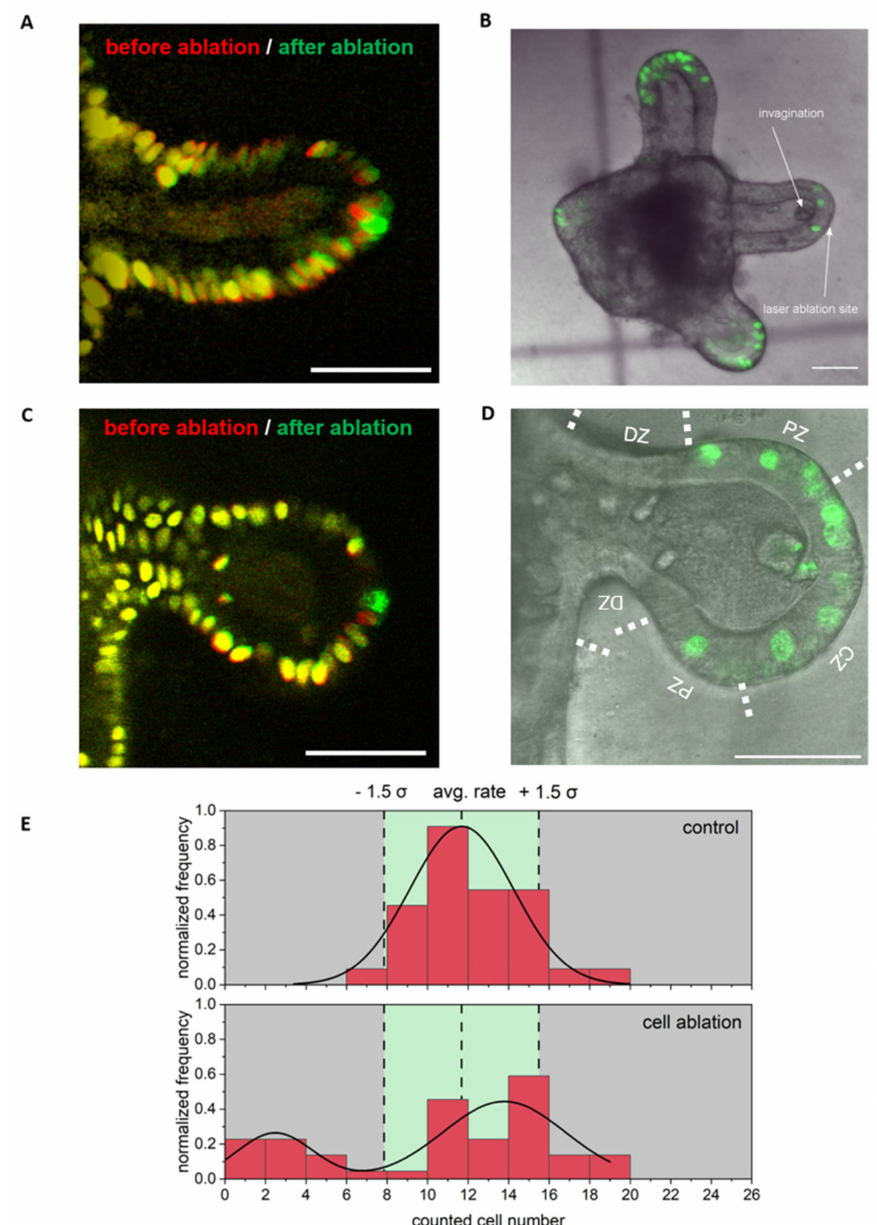
Figure 6. Regeneration and proliferation after ablation of a single cell in the crypt. ( A ) and ( C ) Overlay of an image before (red) and after (green) cell ablation. ( B ) Z-projection (84 µ m, z-step size 2 µ m) of the confocal stack of EdU and transmittance images from the same colonoid as shown in ( A ) after fixation and EdU staining, showing a decreased number of EdU positive (green) cells in the ablated area compared to two control crypts. ( D ) Z-projection (104 µ m, z-step size 2 µ m) of a confocal stack of EdU and transmittance images from the same colonoid, as shown in C, after fixation and EdU staining, showing many EdU positive (green) cells and the invagination of the ablated cell mass in this area. The differentiated zone (DZ), proliferative zone (PZ), and crypt zone (CZ) were delineated from each other by dashed line. ( E ) The frequency of EdU positive cells (green), indicating the proliferation rate points to two scenarios. Either normal proliferation occurs or proliferation within the crypts and the proliferative area is almost completely prevented in comparison with neighboring crypts. Scale bars 50 µ m and n ≥ 49 colonoids. The 3D dataset to ( B ) and ( D ) is provided as Supplementary Videos S5 and